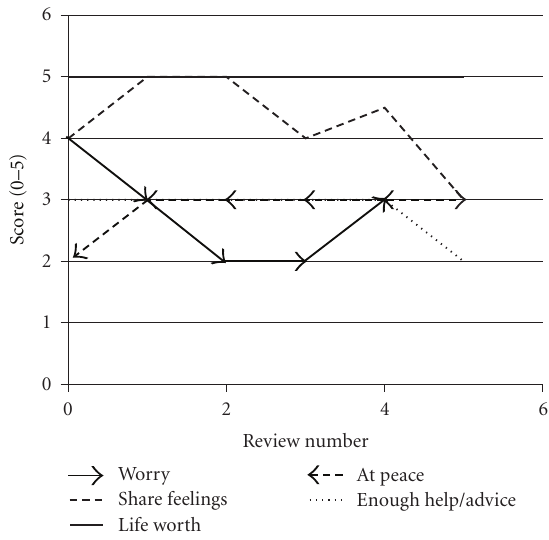
Figure 4: Changes in median APCA POS score for psychosocial domains. This graph depicts the changes in median scores for ques- tions 3–7, from baseline to review number